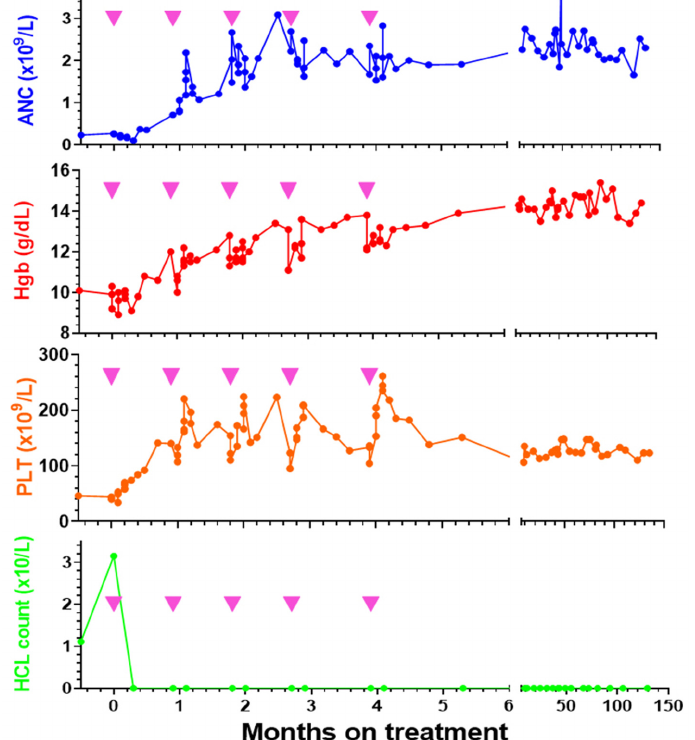
Figure 2. Patient HH17 was treated with Moxe 50 μ g/Kg QOD ×3 for 5 cycles, with the cycles indicated by the inverted pink triangles. Minimal residual disease (MRD)-free complete remission (CR)